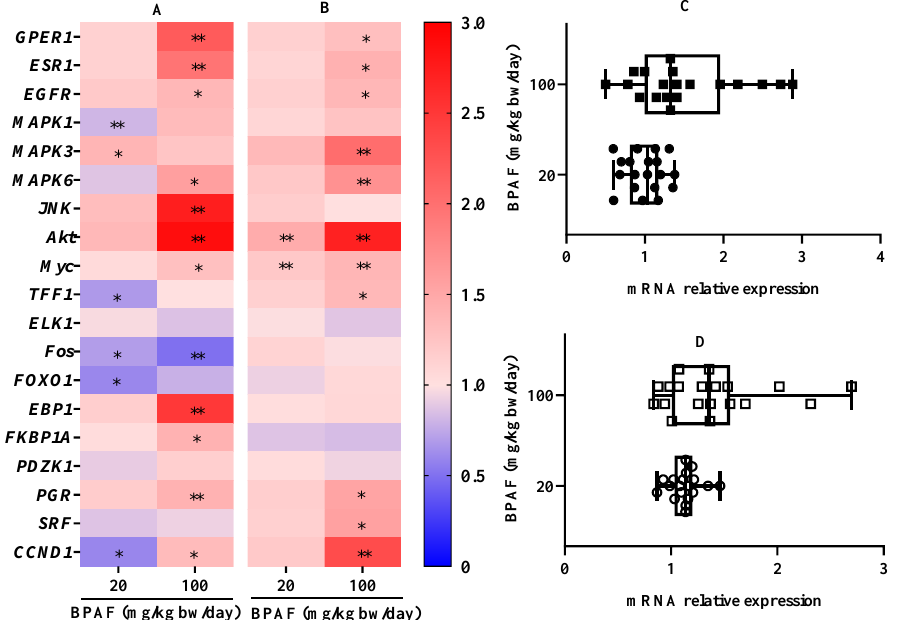
Figure 3. Effect of BPAF exposure for 15 days on the mRNA relative expression of 19 genes associated with the PI3K/Akt and MAPK pathways in in ovary and uterus of female nude mice with SK- BR-3 xenograft tumor. ( A ): the mRNA relative expression of 19 genes in ovary; ( B ): the mRNA relative expression of 19 genes in uterus; ( C ): the data distribution of mRNA relative levels of 19 genes in ovary; ( D ): the data distribution of mRNA relative levels of 19 genes in uterus. The data represented the mean of six parallel mice samples. * p < 0.05 and ** p < 0.01, relative to SK-BR-3 bearing tumor control.